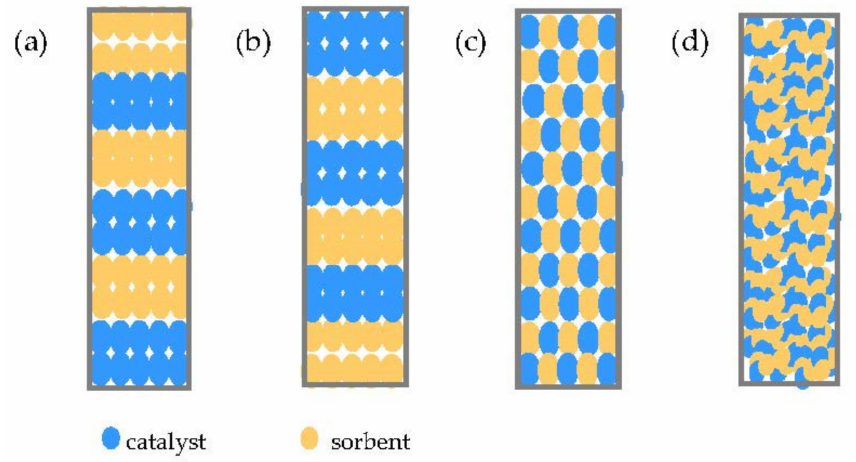
Figure 15. Possible catalyst–sorbent configurations: ( a ) alternate layers of catalyst and sorbent, ( b ) alternate layers of sorbent and catalyst, ( c ) pre-mixed sorbent catalyst, ( d ) hybrid